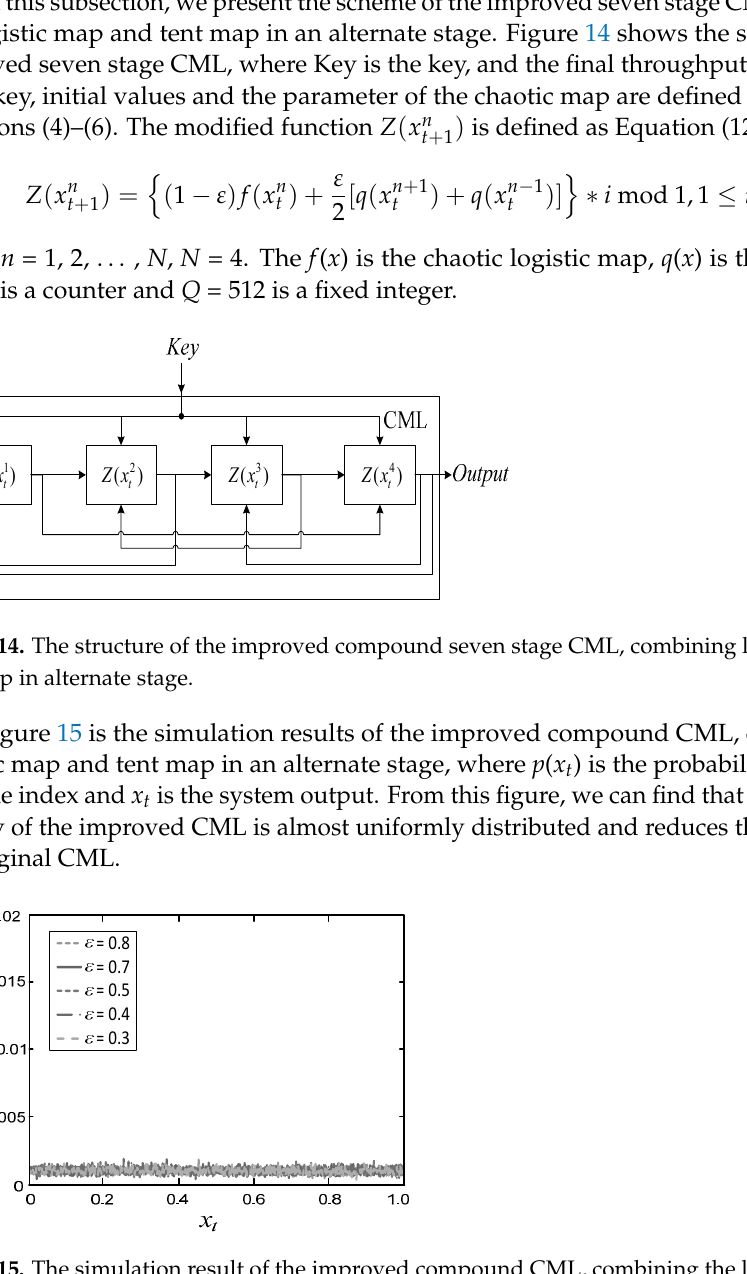
Figure 15. The simulation result of the improved compound CML, combining the logistic map and tent map in an alternate stage.